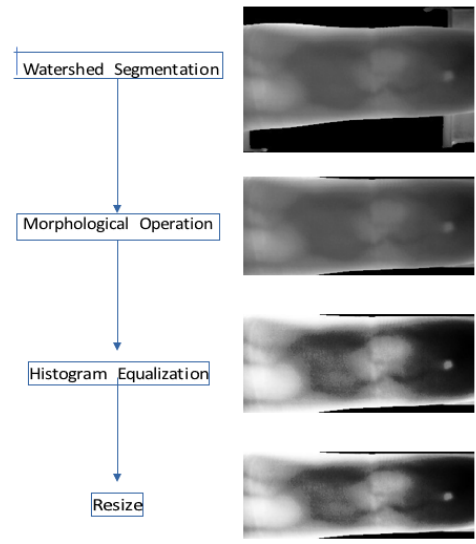
Figure 3. Preprocessing. Figure 3.